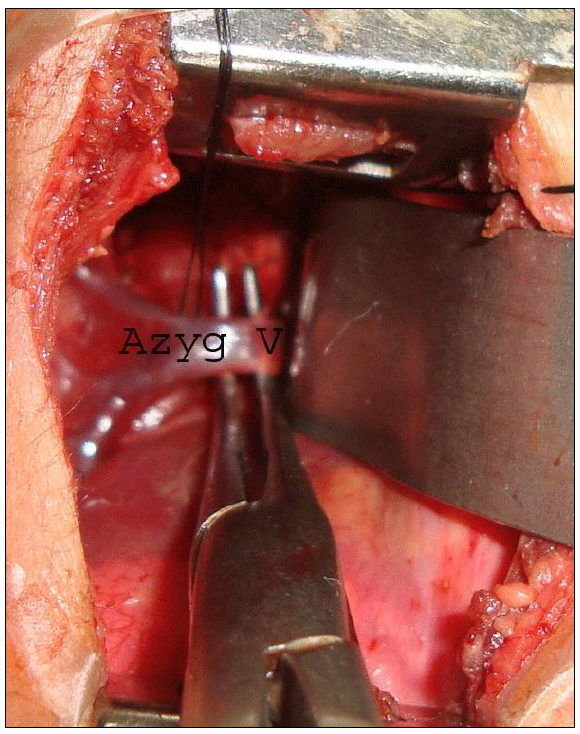
Figure 1: A tunnel is being created medial to the preserved arch of azygos